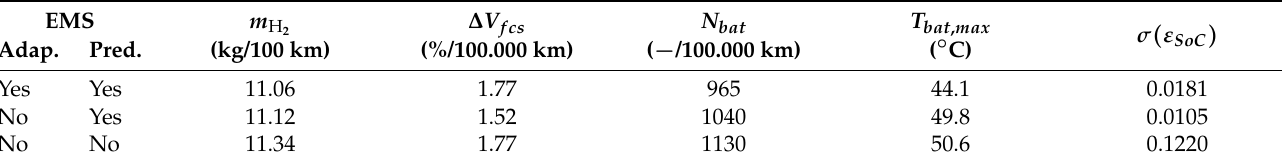
Table 1. Comparison of KPIs for the specific driving cycle under investigation at T amb = 20 ◦